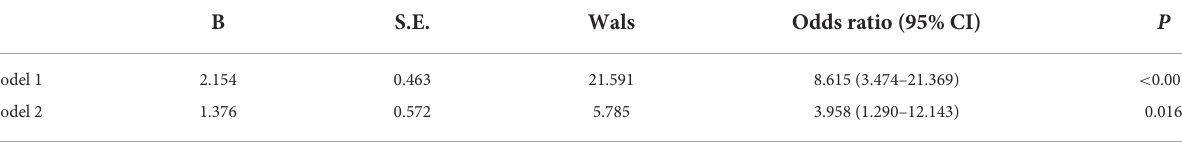
TABLE 3 Relation of serum annexin A7 levels to early neurological deterioration using multivariate analysis.